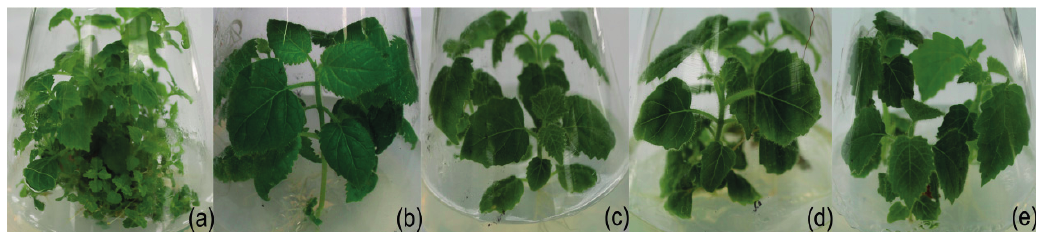
Figure 2. Detection of phytoplasma 16S rRNA in MMS-treated PaWB plantlets. 1 : PaWB plantlets; 2 : 15 mg·L − 1 MMS; 3 : 30 mg·L − 1 MMS; 4 : 45 mg·L − 1 MMS; 5 : HP; 6 :